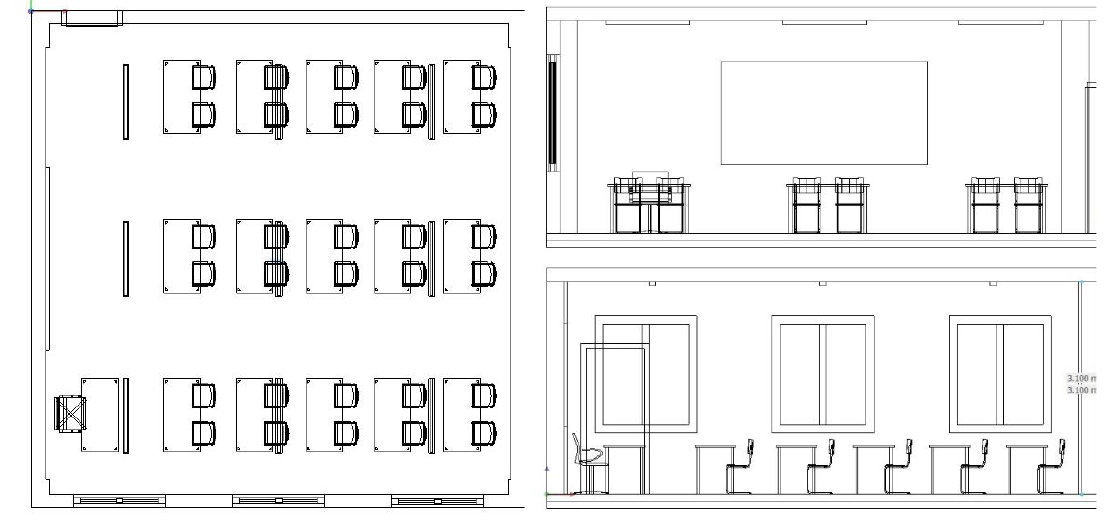
Figure 1 Plan and sections of the sample classroom